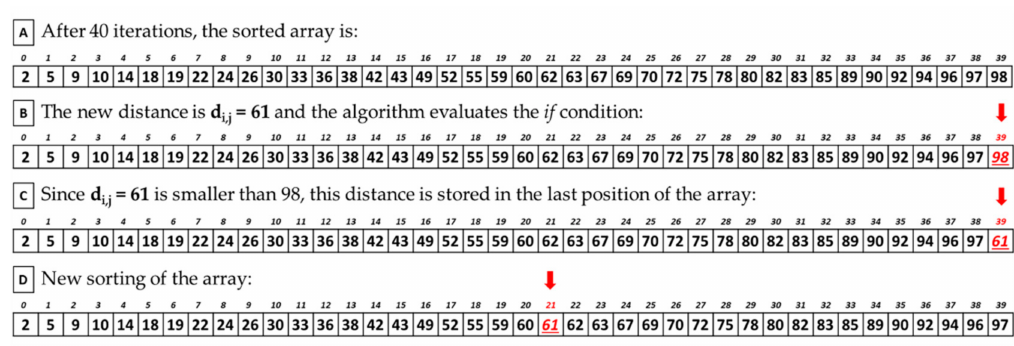
Figure 7. KNN searching new distance evaluation